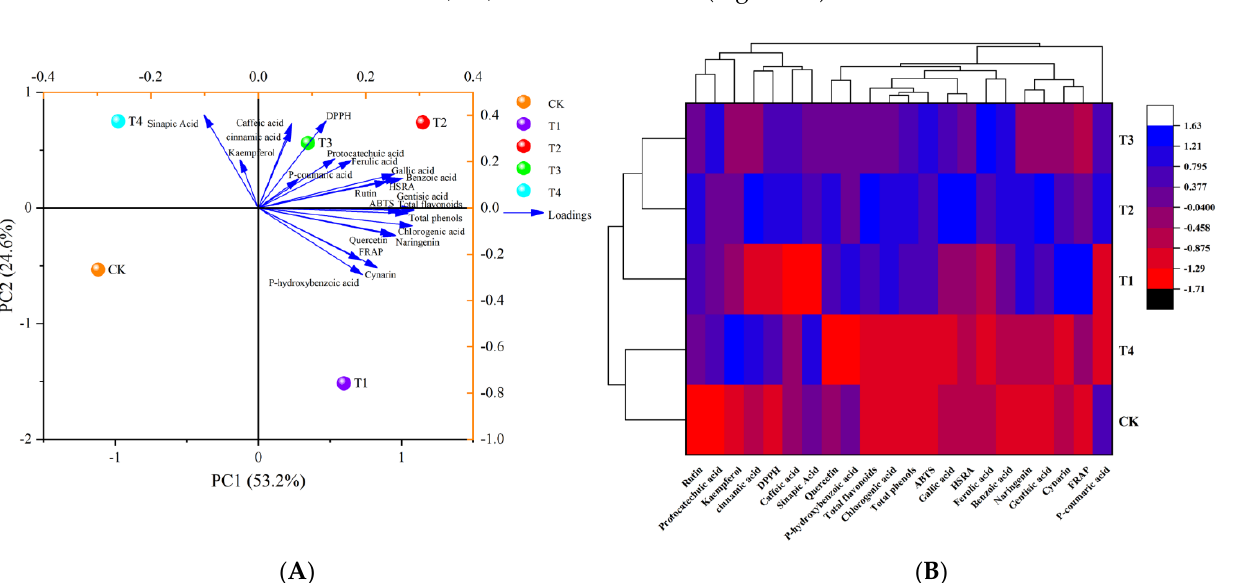
Figure 3. Principal component analysis ( A ) and cluster analysis ( B ) of polyphenols and antioxidant activity in tomato fruits under different levels of water deficit. ABTS, HSRA, FRAP, and DPPH are defined in Figure 1’s legend. The abbreviations CK, T1, T2, T3, and T4 are defined in the footnote of Table 1.